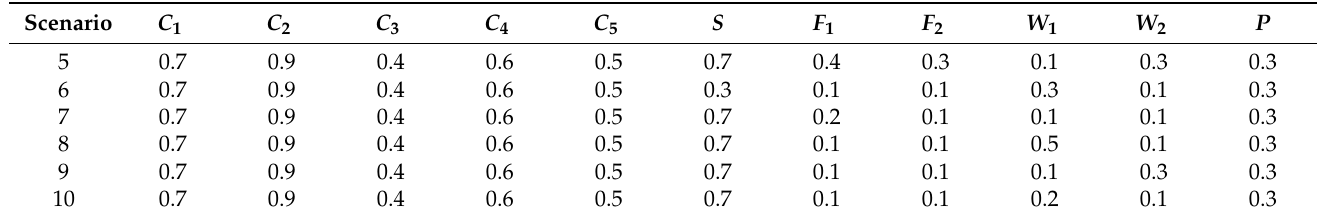
Table 9. Parameter assignment for MATLAB simulation of RDP vs. hydropower developer